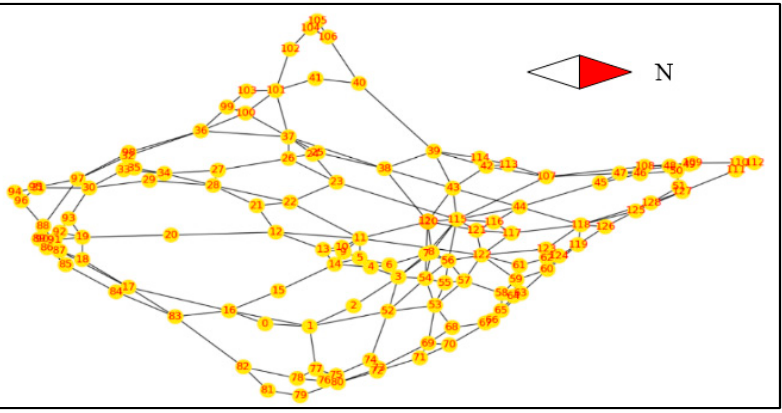
Figure 2. Item delivery network from the map.